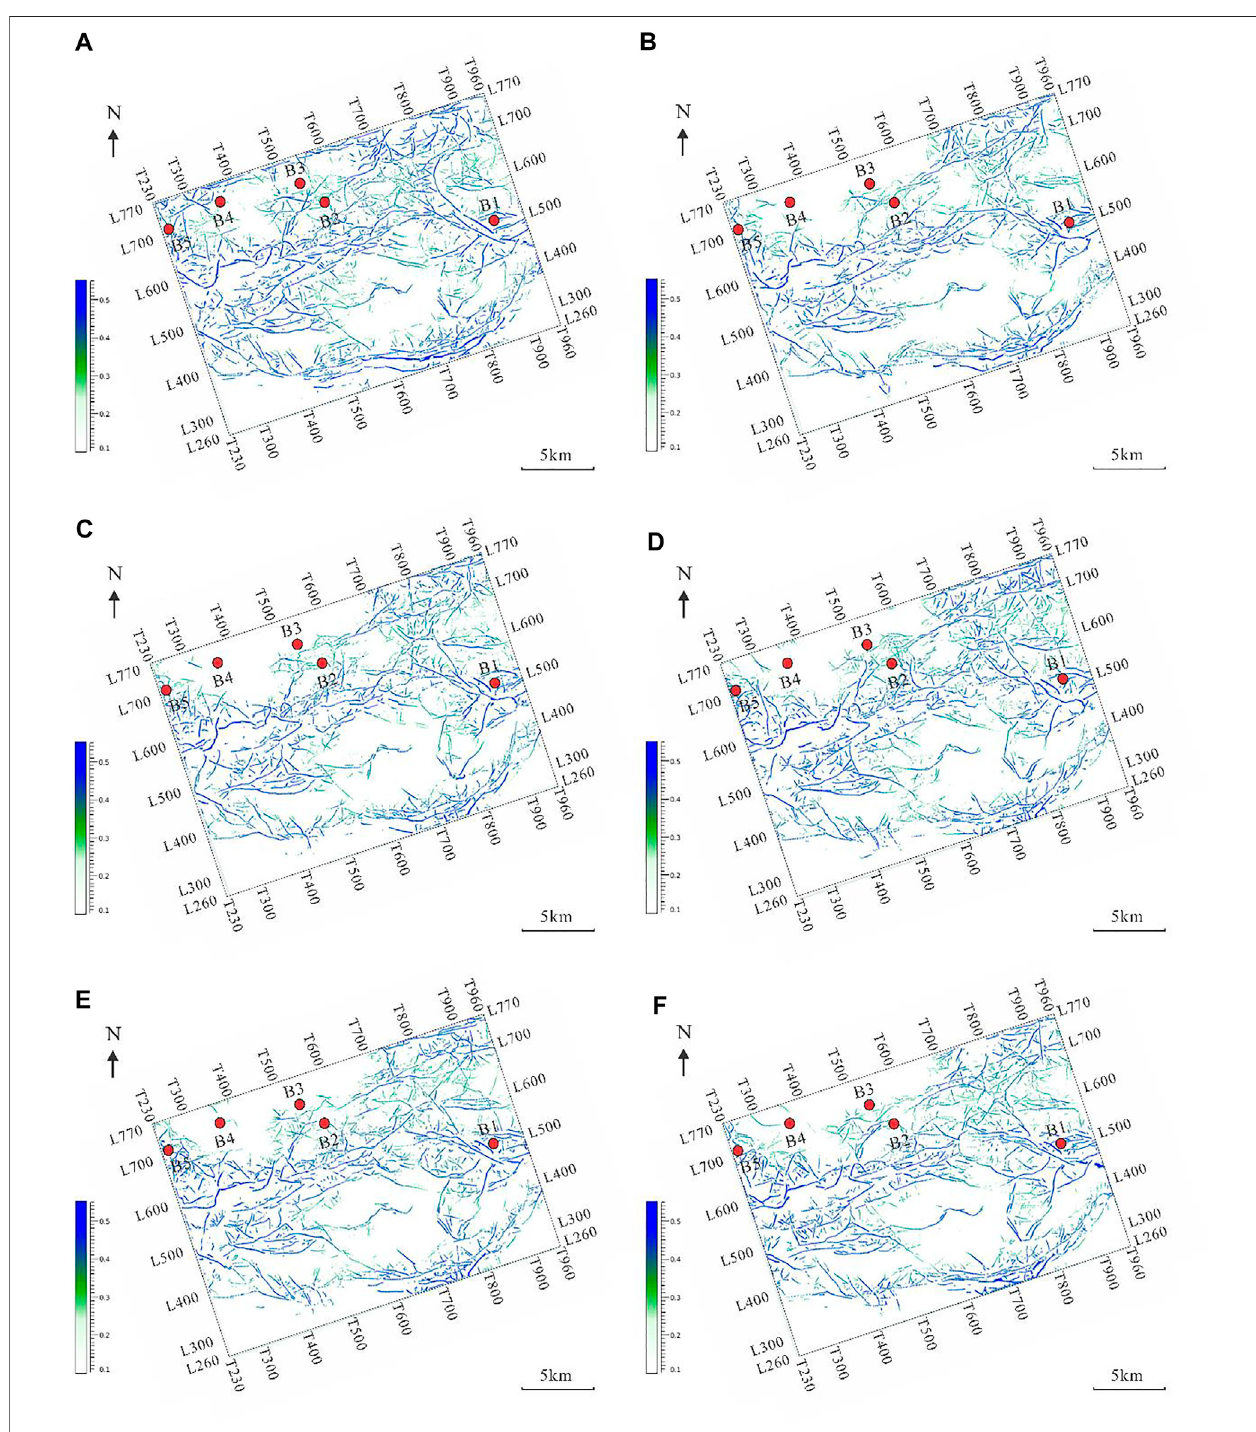
FIGURE 6 | Plane view of fracture prediction of Likelihood attribute by azimuth in the upper sweet spot. (A) Azimuth 0 ° – 30 ° . (B) Azimuth 31 ° – 60 ° . (C) Azimuth 61 ° – 90 ° . (D) Azimuth 91 ° – 120 ° . (E) Azimuth 121 ° – 150 ° . (F) Azimuth 150 ° – 180 ° .